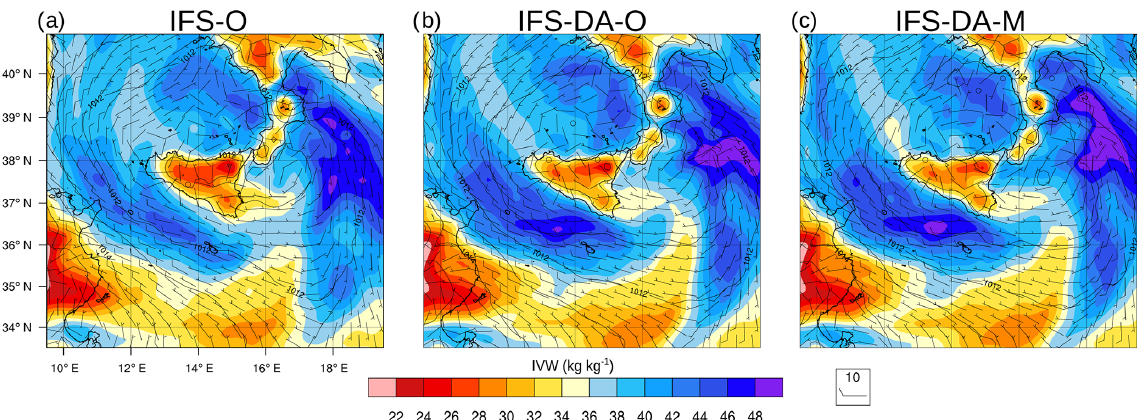
Figure 8. Column IWV (integrated water vapour; kgkg − 1 , colour), sea level pressure (hPa; contours), and wind direction and speed (barbs) at a height of 10m at 03:00UTC on 12 August 2015 for (a) IFS-O, (b) IFS-DA-O, and (c) IFS-DA-M respectively.